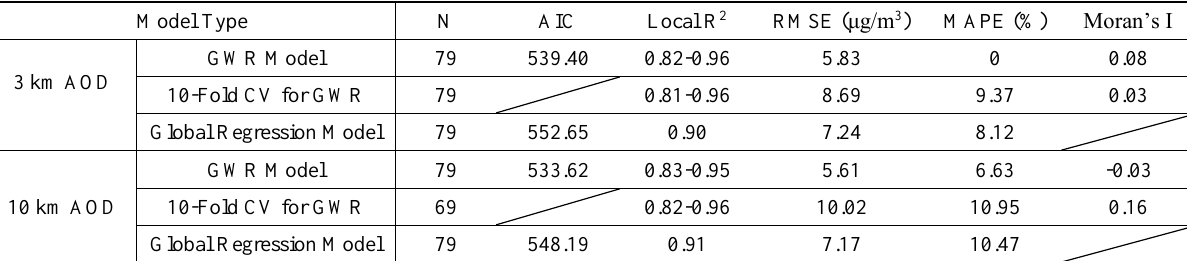
Table 2. Model results of the GWR model, 10-fold CV and the corresponding Global Regression model from the 3 km and 10 km